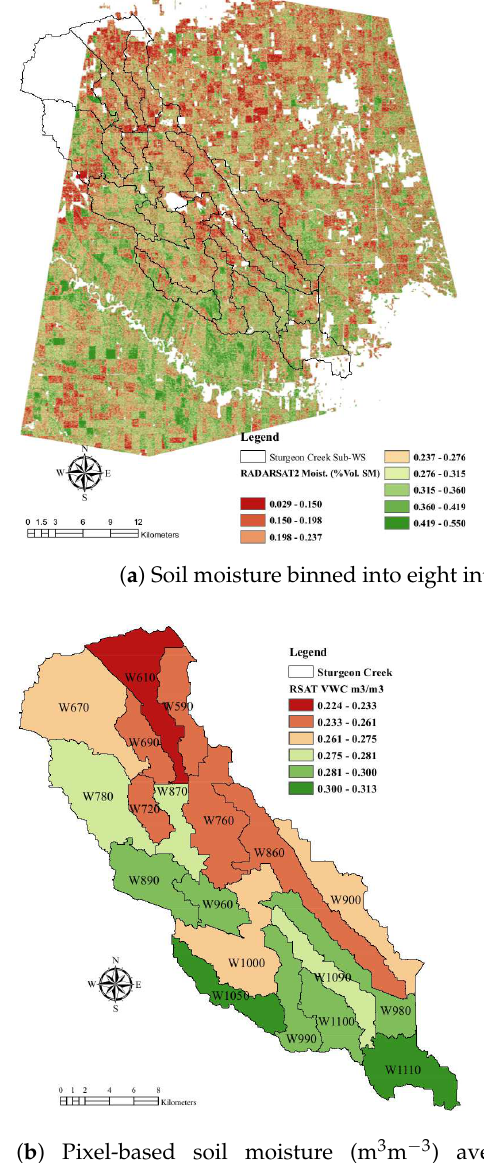
Figure 4. Soil Moisture retrieved using a RADARSAT-2 satellite image acquired on 15 October